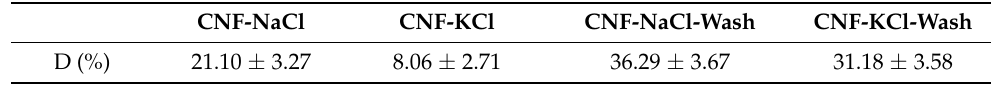
Table 2. Dispersion index of samples.